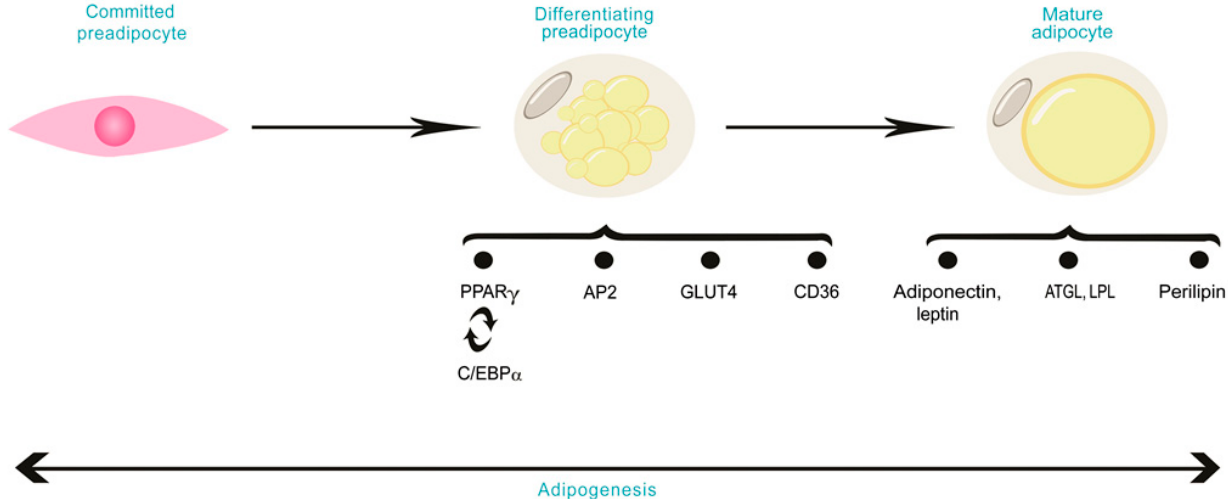
Figure 2. Overview of key factors involved in adipogenesis. Committed preadipocyte encounters growth arrest which leads to the formation of differentiating preadipocyte. Subsequently, differentiation occurs, and a mature adipocyte is formed.